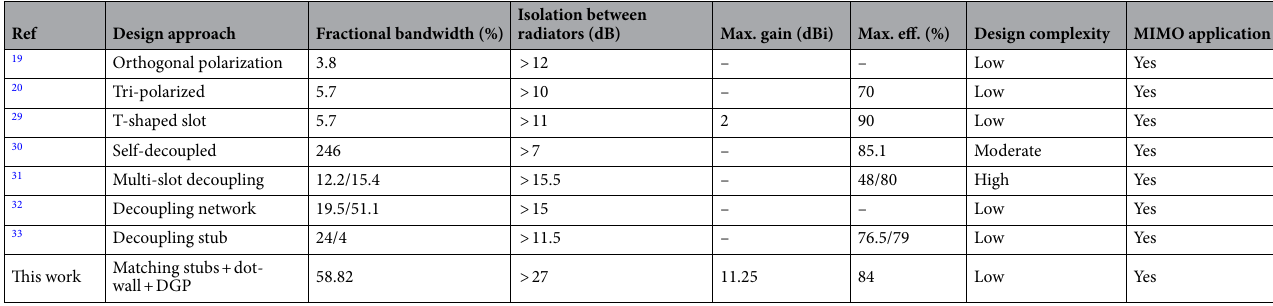
Table 5. State-of-the-art